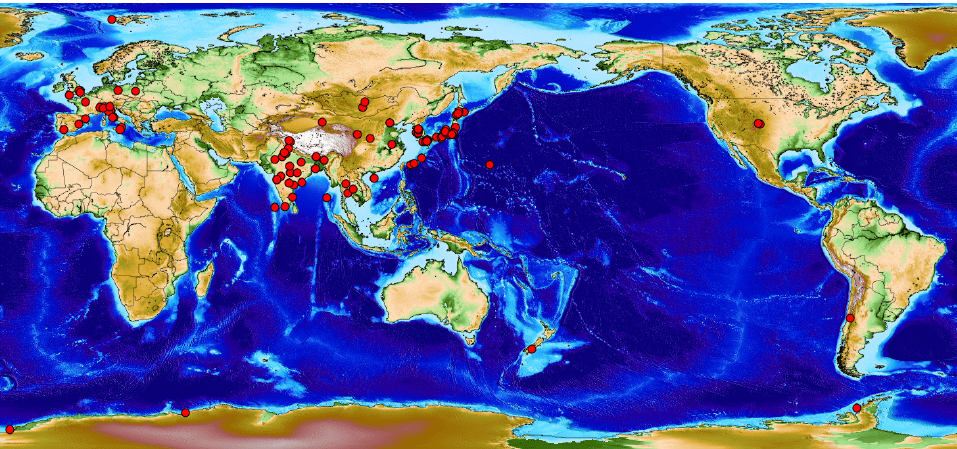
Figure 1. A map of the sky radiometer sites.